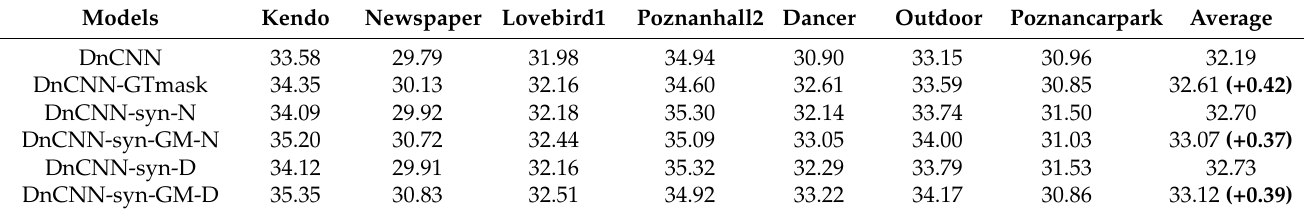
Table 8. SVQE comparison measured by PSNR among DnCNN-based schemes and that with ground are abbreviated as DnCNN-syn-GM-N and DnCNN-syn-GM-D, respectively. The performance gains of DnCNN-based schemes with ground truth DIBR distortion masks over DnCNN-based schemes without masks are highlighted in